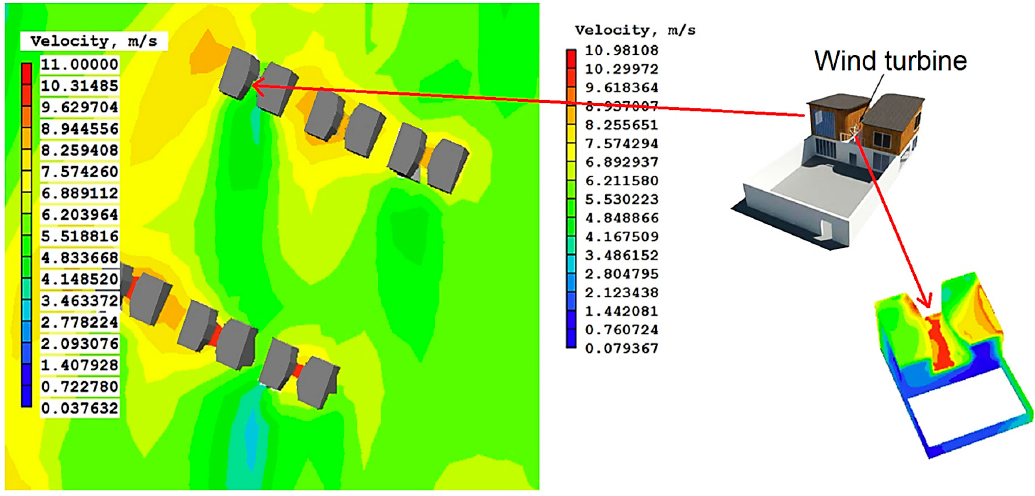
Figure 16. Wind amplification effect of the designed building shape in sample building(s) [19].